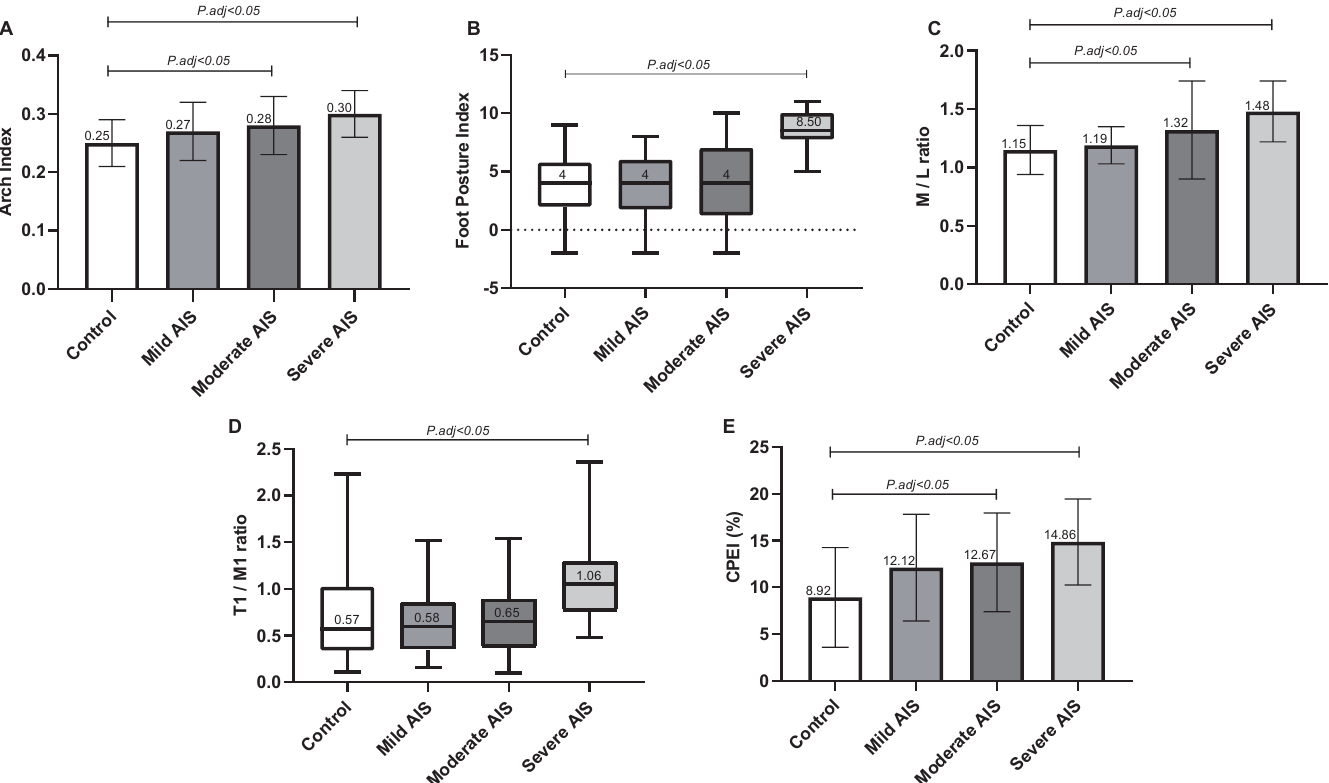
Fig 2. Results of between groups comparison with Bonferroni correction in Arch Index (A), Foot Posture Index (B), M/L ratio (C), T1/M1 ratio (D), and CPEI (E). M/L ratio, the ratio of the medial heel impulse to the lateral heel impulse; T1/M1 ratio, the ratio of the impulse from the big toe to the impulse from the first metatarsal; CPEI, the center of pressure excursion index; AIS, adolescent idiopathic scoliosis; P.adj, adjusted p-value.